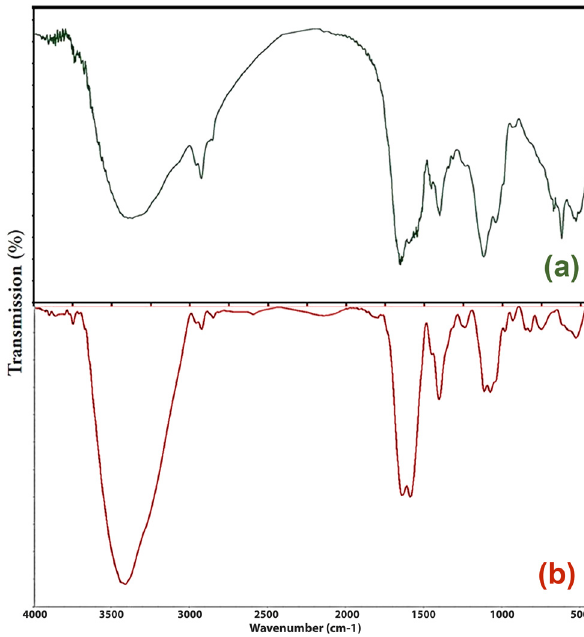
Figure 3: FTIR spectra of Spirulina extract ( a ) and Sp SeNPs ( b )